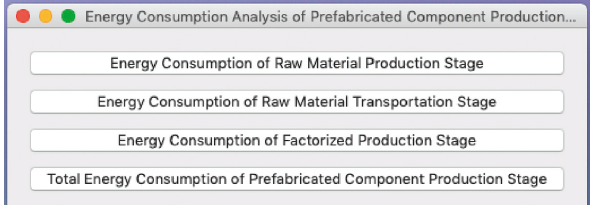
Figure 10: The main window of the energy consumption calcu- lation